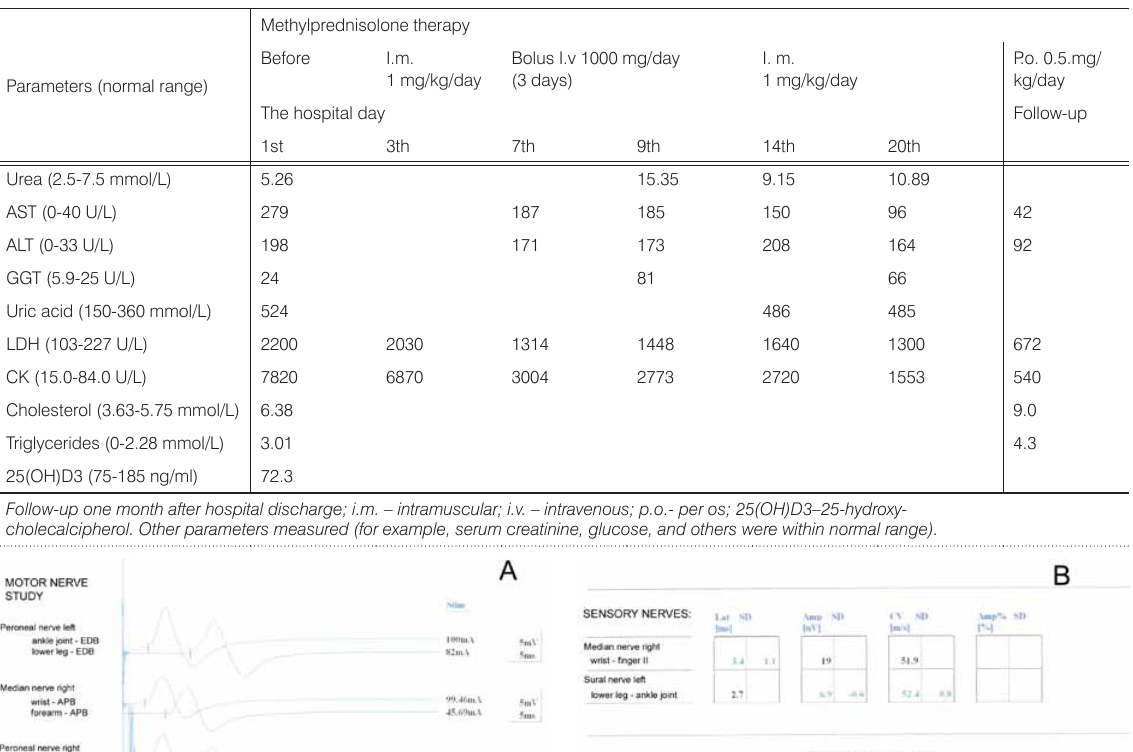
Table 1. Selected laboratory parameters during corticosteroid therapy (patient with polymyositis)